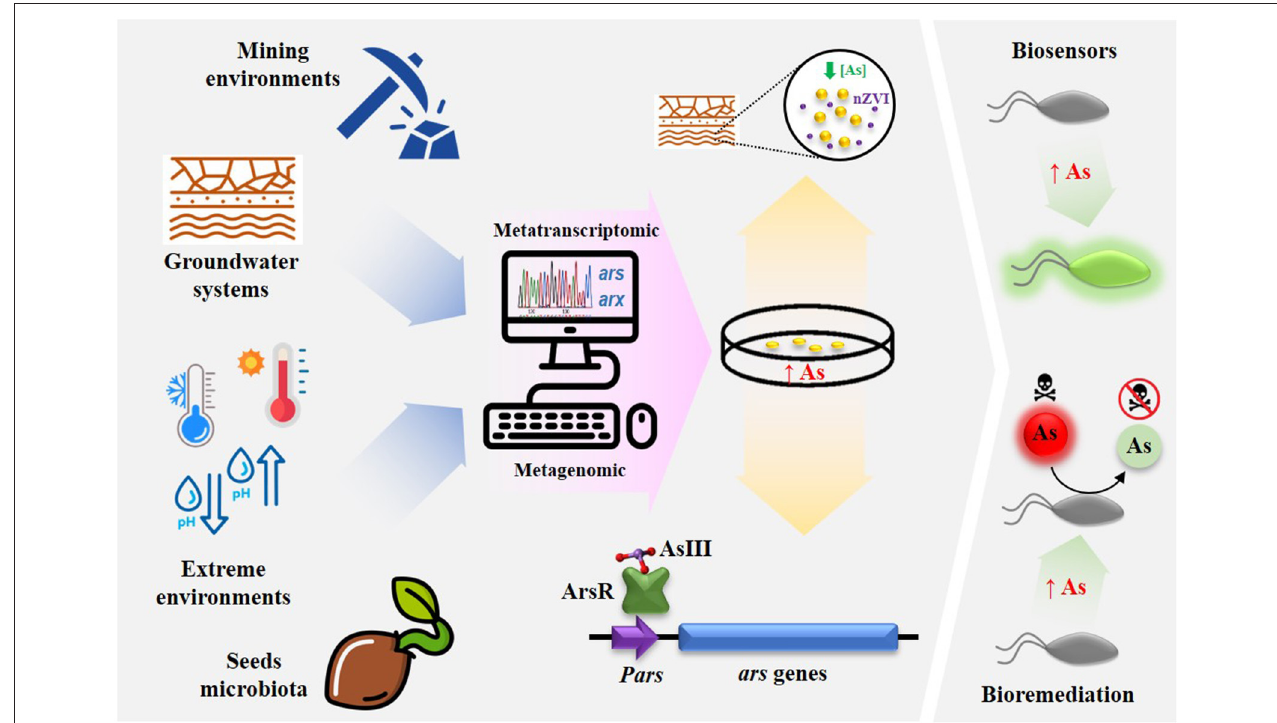
FIGURE 1 | Conceptual summary depicting different environments to detect microorganisms harboring As tolerance strategies are important tools for arsenic detection (Biosensensors) and